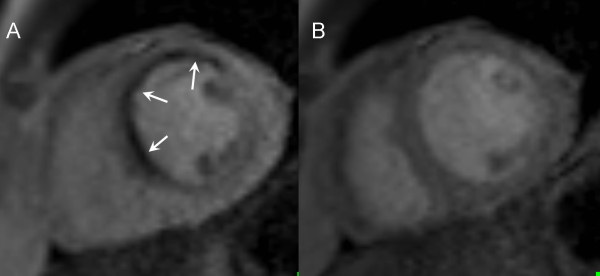
A representative example from a CMR perfusion scan during high dose adenosine stress. This is a 69-year-old diabetic patient with a significant stenosis of the left anterior descending coronary artery. Note the marked perfusion defect in the septum and anterior wall (arrows). The resting perfusion scan (panel B) is normal and shows homogeneous enhancement in all myocardial regions.